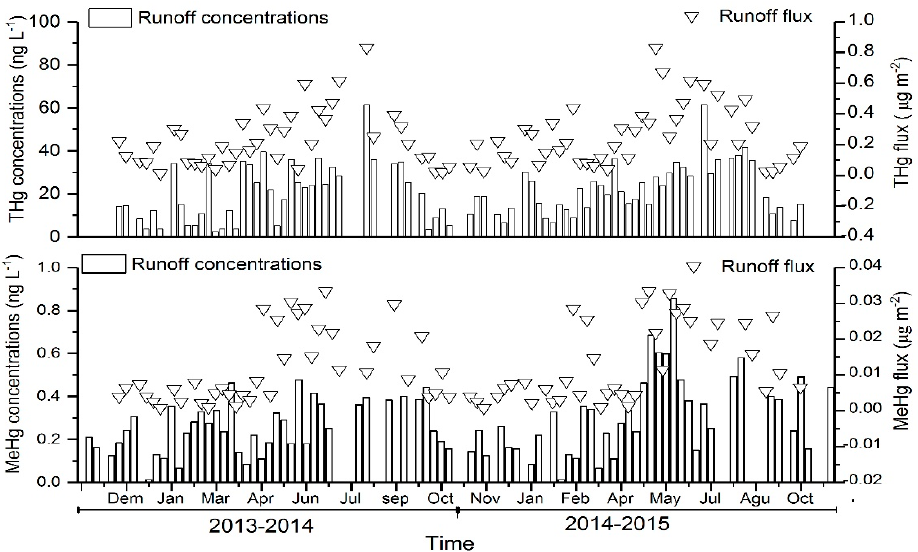
Figure 4. THg and MeHg concentrations and fluxes in the forest runoff collected in the study forest stand from 2013 to 2015.